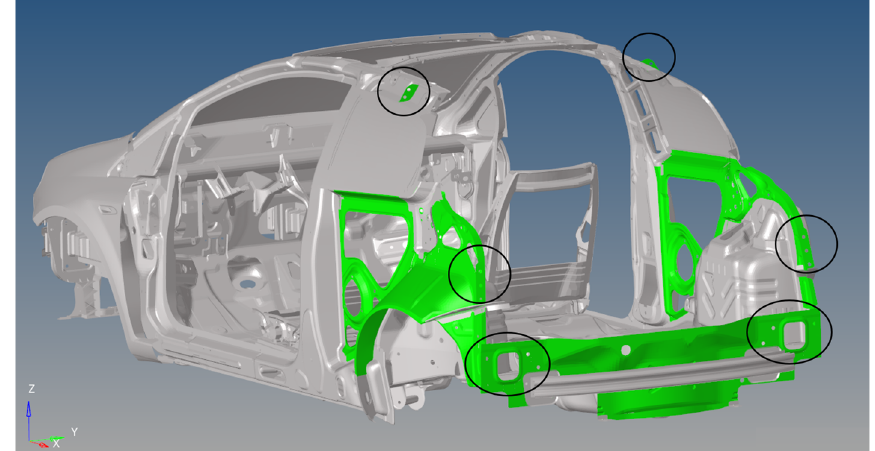
Figure 12. Areas of the rear part where the connections were obtained with screws.